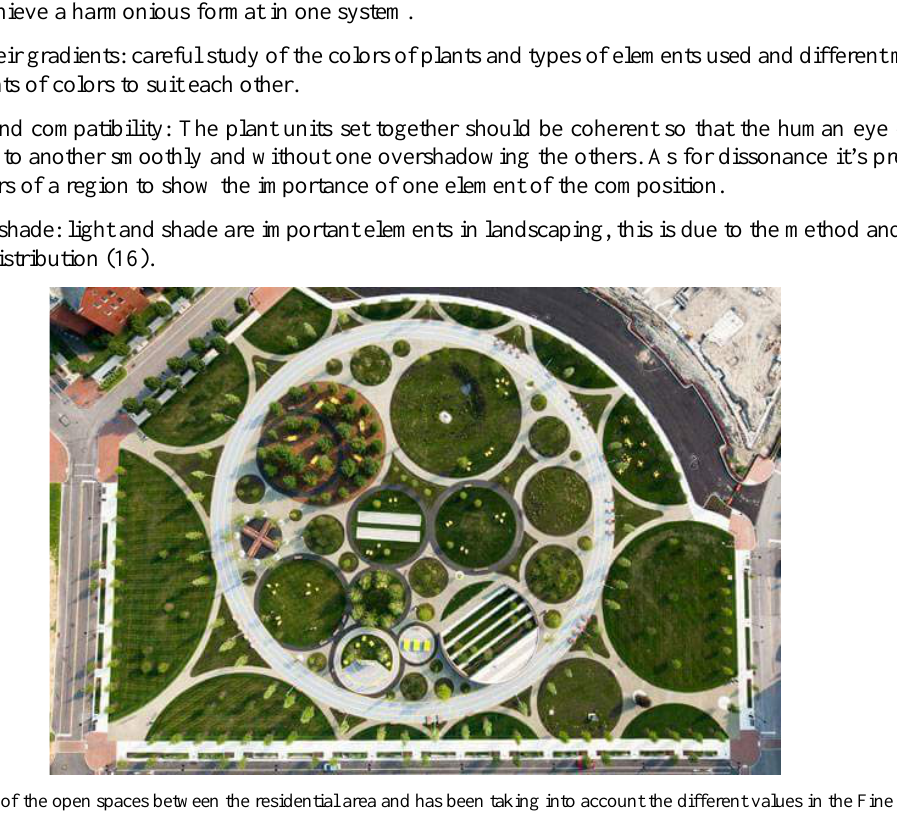
Figure (9) One of the open spaces between the residential area and has been taking into account the different values in the Fine Design The concept of